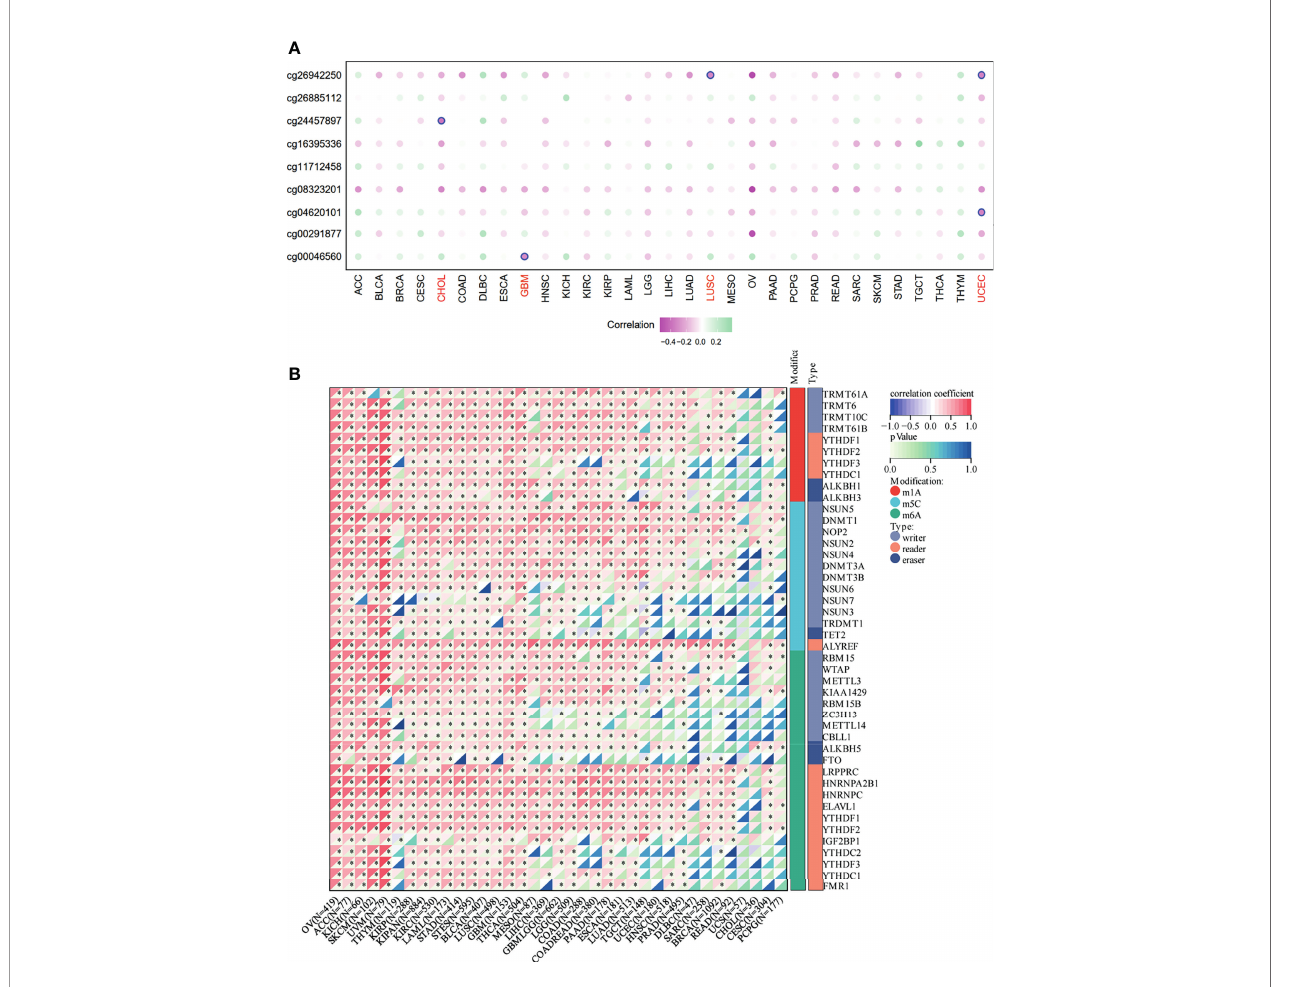
FIGURE 2 | DNA methylation and RNA modi fi cation in SNRPA1. (A) The correlation of SNRPA1 expression and methylation degree in pan-cancer. (B) The correlation of SNRPA1 expression and RNA modi fi cation regulator expression in pan-cancer. *p <